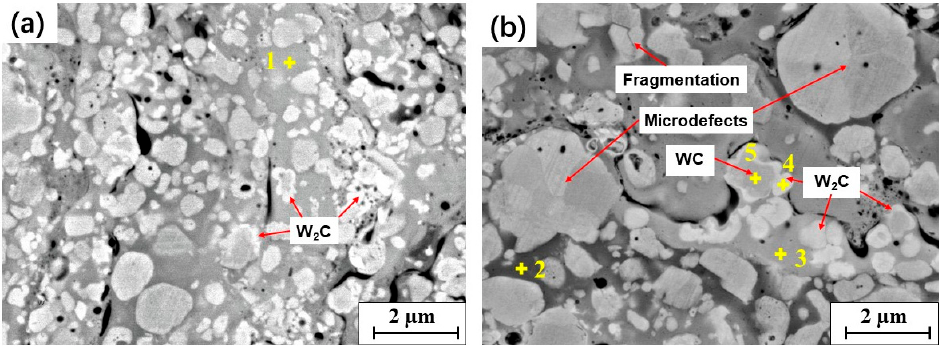
Figure 6. W 2 C formation and fragmentation of the WC phases in the coatings: ( a ) B1; ( b ) B2. Table 4. EDS analysis results (wt%) of the detected points marked in Figure 6.